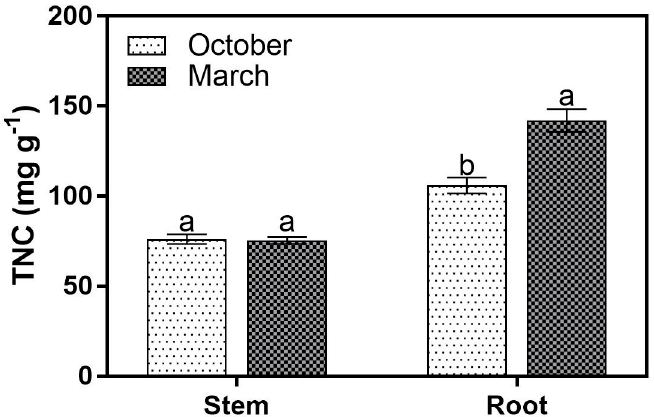
Figure 4. Mean (±SE) TNC concentrations (mg g − 1 ) for species (PT = Pinus tadea , PE = Pinus elliottii , and PP = Pinus palustris ) by organ (stem and root) averaged across months (October and March). Bars with different letters within an organ indicate significant difference ( α = 0.05).